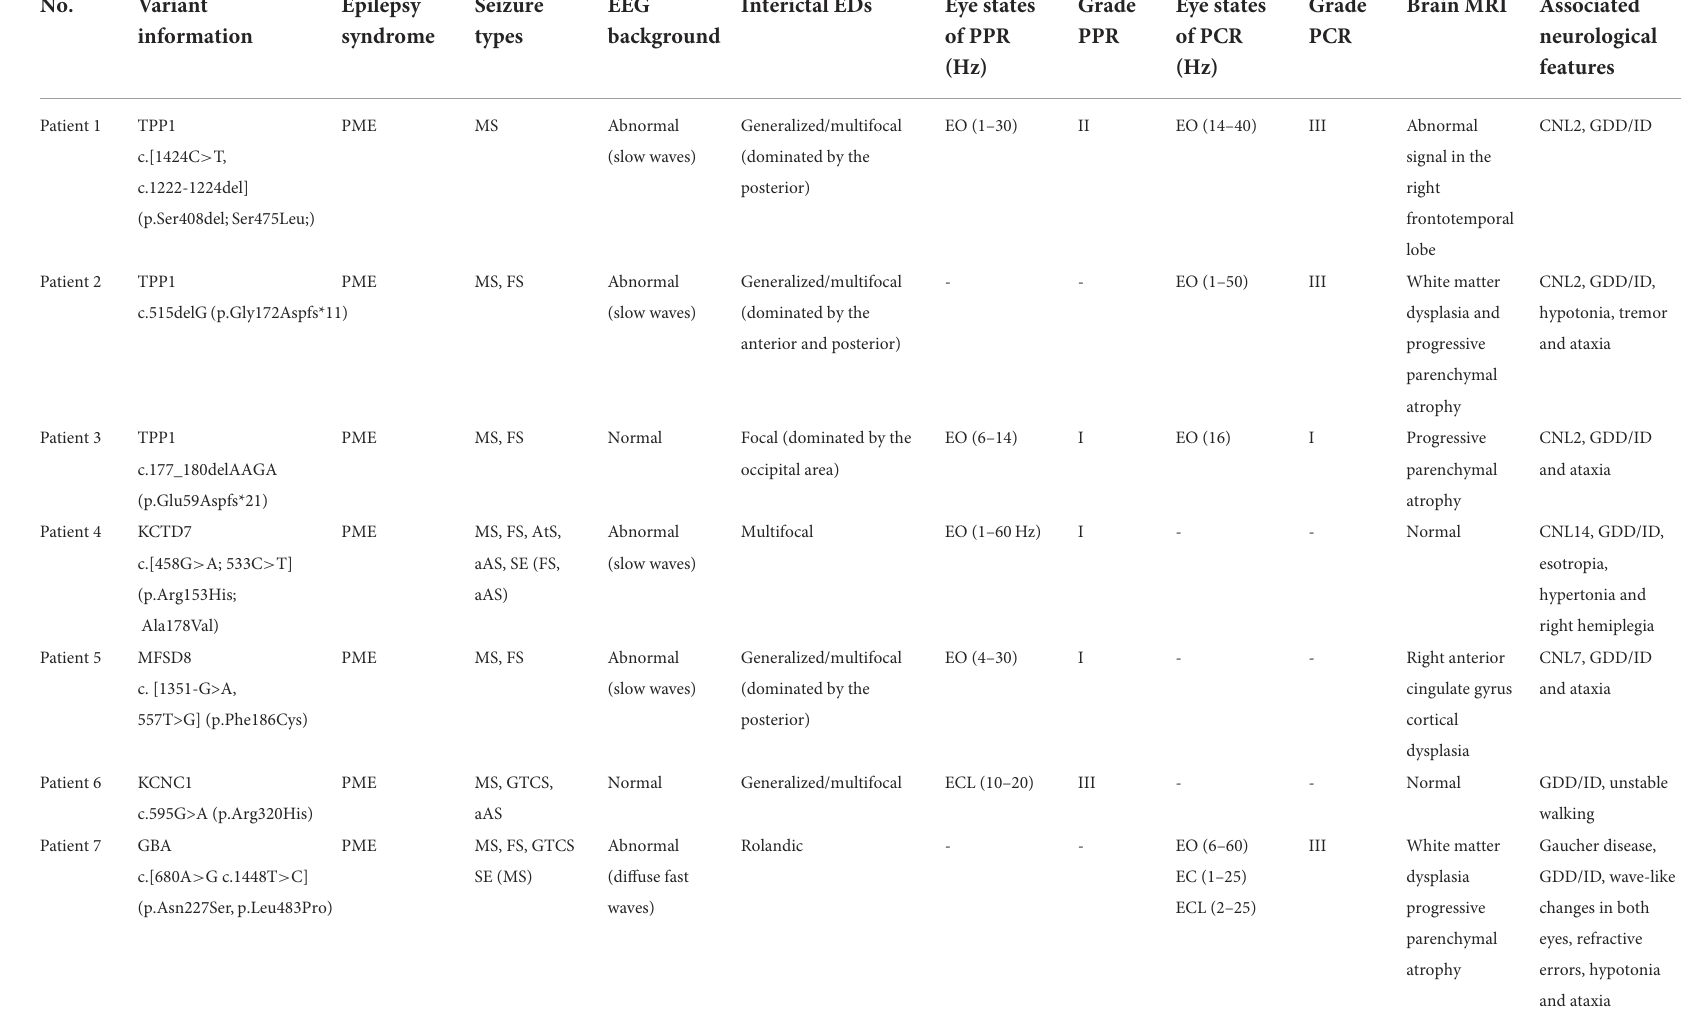
TABLE 1 Clinical characteristics of 35 pathogenic/likely pathogenic epileptic patients with